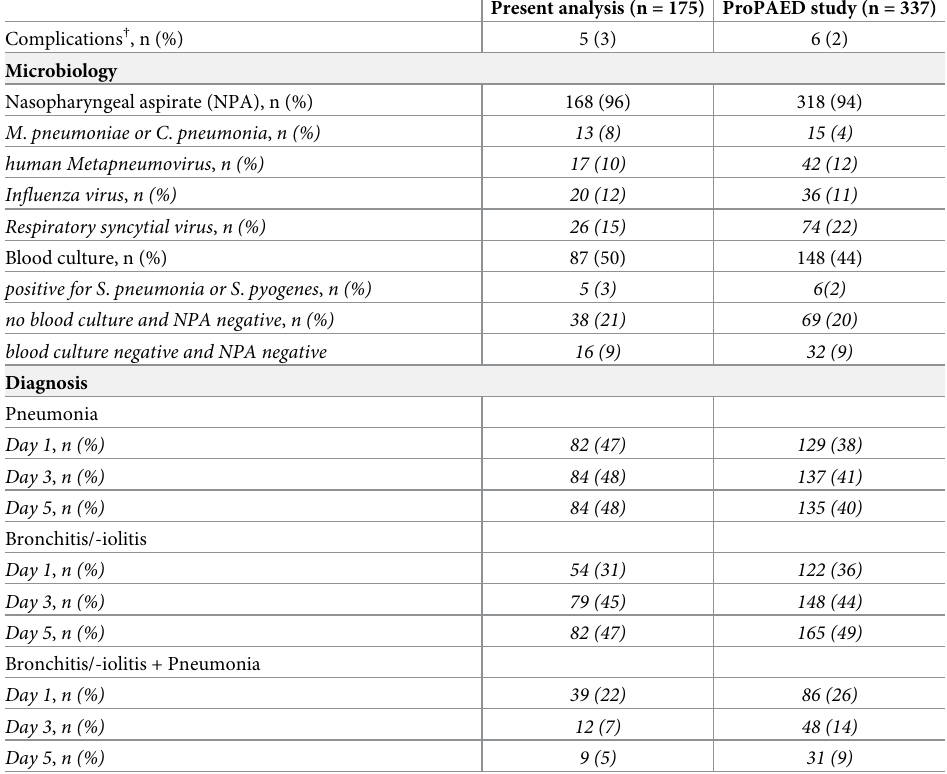
Table. Five patients developed complications of LRTI. All recovered well, there were no deaths (S3